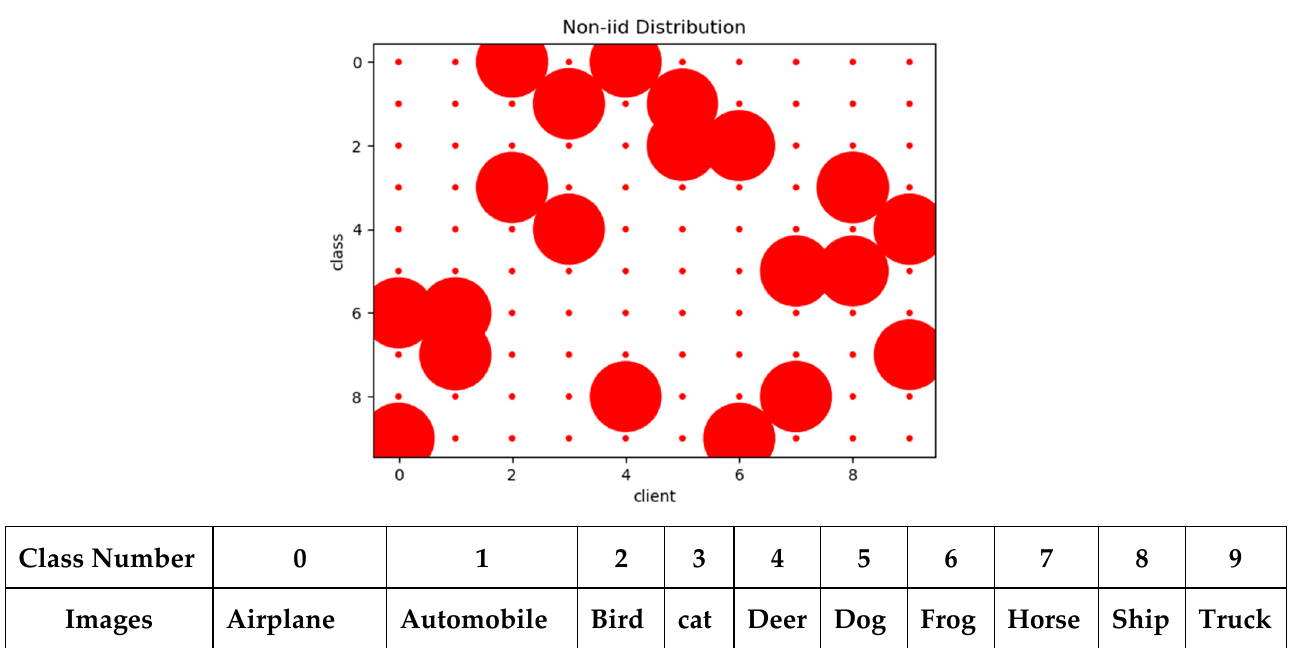
Figure 7. An example of non-IID training data distribution (horizontal-axis: client number and vertical-axis: image class number).